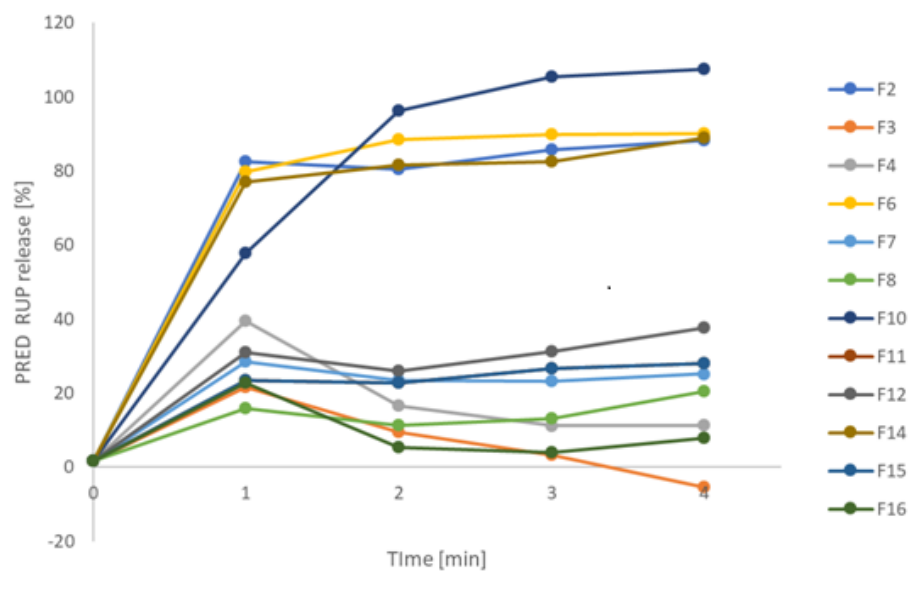
Figure 9. Electronic tongue prediction of RUP release (the results for independent test